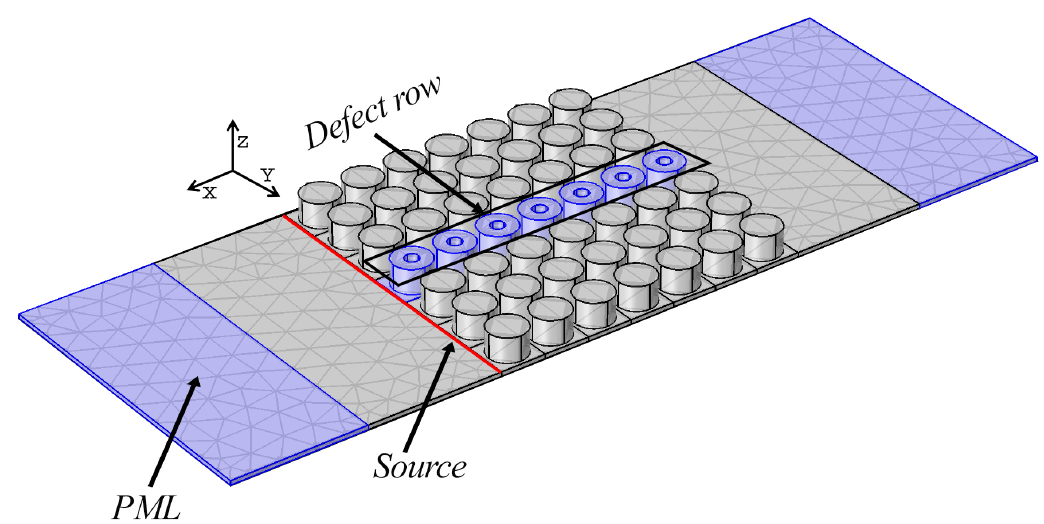
Figure 1. Phononic crystal with a square lattice of solid pillars on top of the plate structure. The void pillars are the filtering mechanism of the structure.